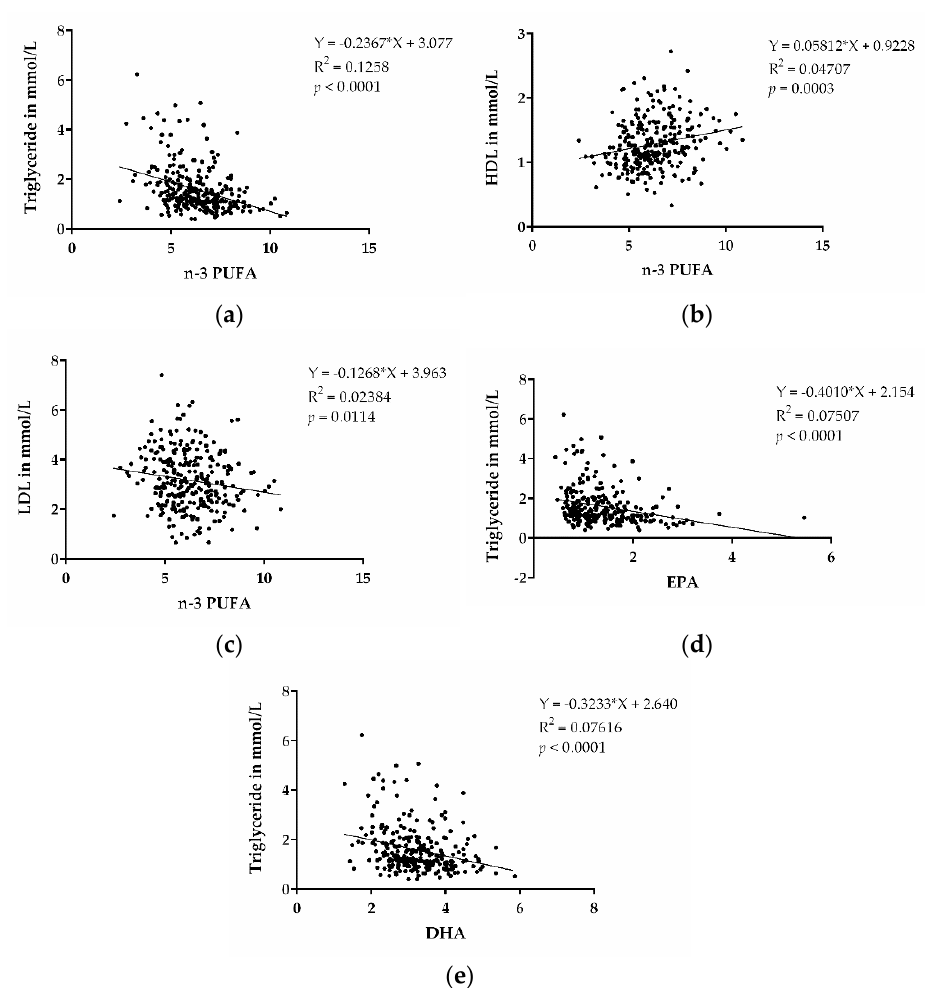
Figure 2. n-3 PUFAs and dyslipidemia. ( a ) Correlation between TGs and n-3 PUFA (EPA + DPA + DHA). ( b ) Correlation between HDL cholesterol and n-3 PUFA (EPA + DPA + DHA). ( c ) Correlation between LDL cholesterol and n-3 PUFA (EPA + DPA + DHA). ( d ) Correlation between TGs and EPA. ( e ) Correlation between TGs and DHA. ( n = 273).